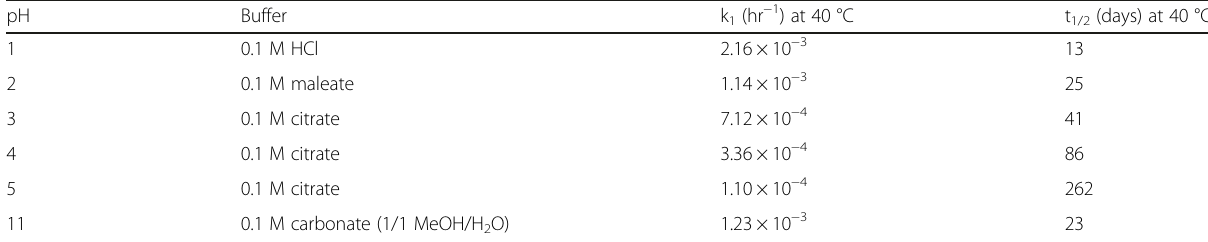
Table 1 pH Stability Data for Indinavir (used with permission from Ref (Crixivan Package Insert. (available at